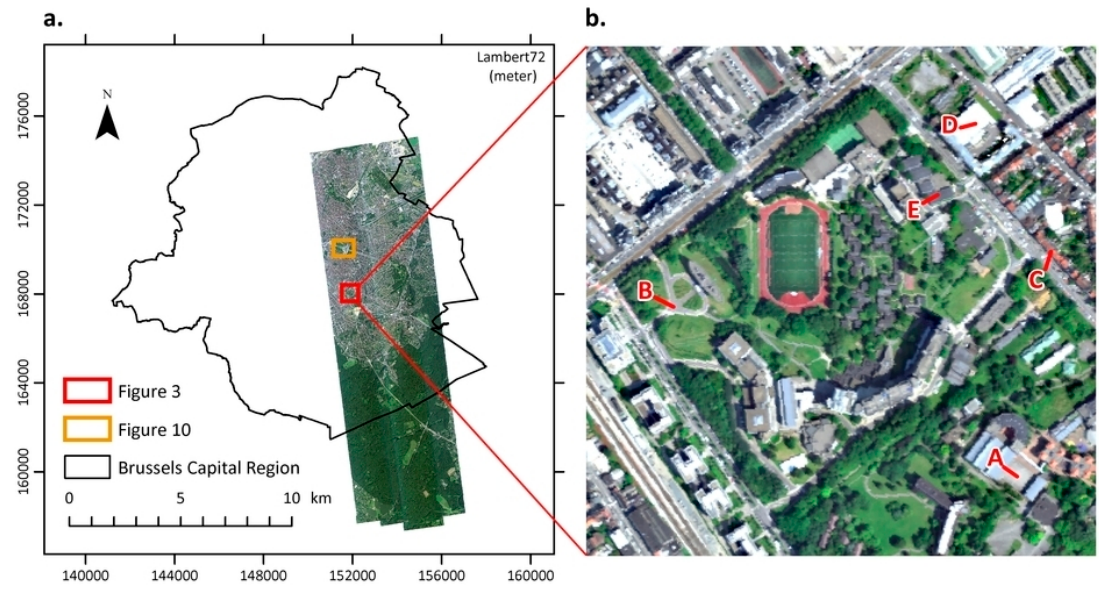
Figure 1. ( a ) RGB-image (R = band 36, G = band 18 and B = band 5) of the 2013 APEX image covering the Eastern part of the Brussel Capital Region and ( b ) inset map for VUB university campus . Annotations in ( b ) refer to material spectra (see below).